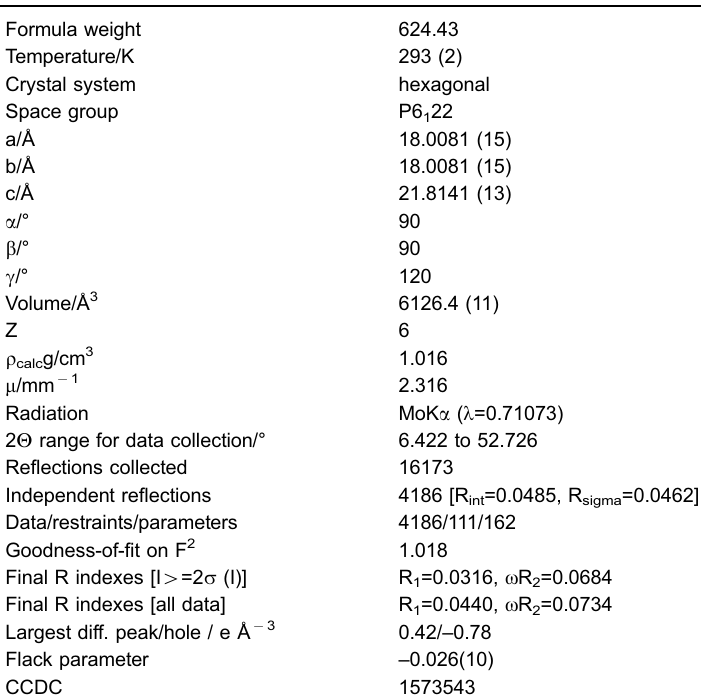
Table 1. Crystal data and structure re fi nements for compound